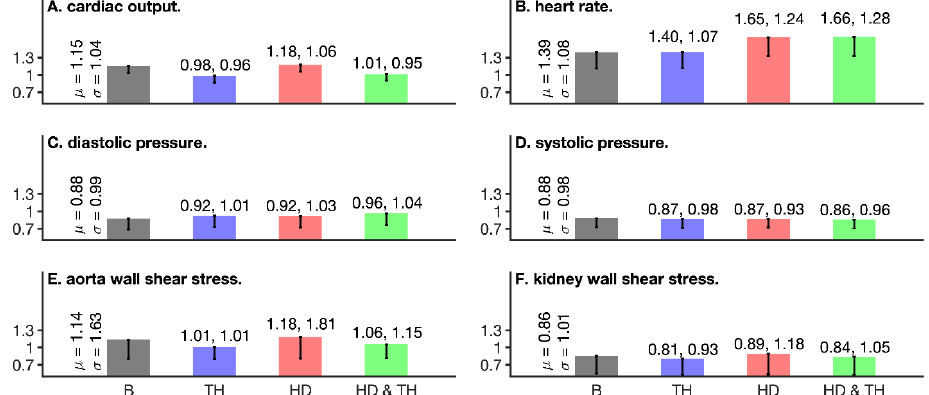
Figure 6. Effects of exercise on clinical measurables. In all panels, data for exercise [37] under baseline (B, gray bars), therapeutic hypothermia (TH, blue bars), dialysis (HD, red bars), and dialysis under TH (HD&TH, green bars) conditions are shown. Panel ( A ) shows cardiac output, ( B ) shows heart rate, ( C ) shows diastolic cardiac pressure, ( D ) shows systolic cardiac pressure, ( E ) shows WSS in the aorta, and ( F ) shows WSS in the right kidney. Mean values and standard deviations relative to the non-exercise baseline case (Figure 3, gray bars and corresponding values) are provided in all panels.